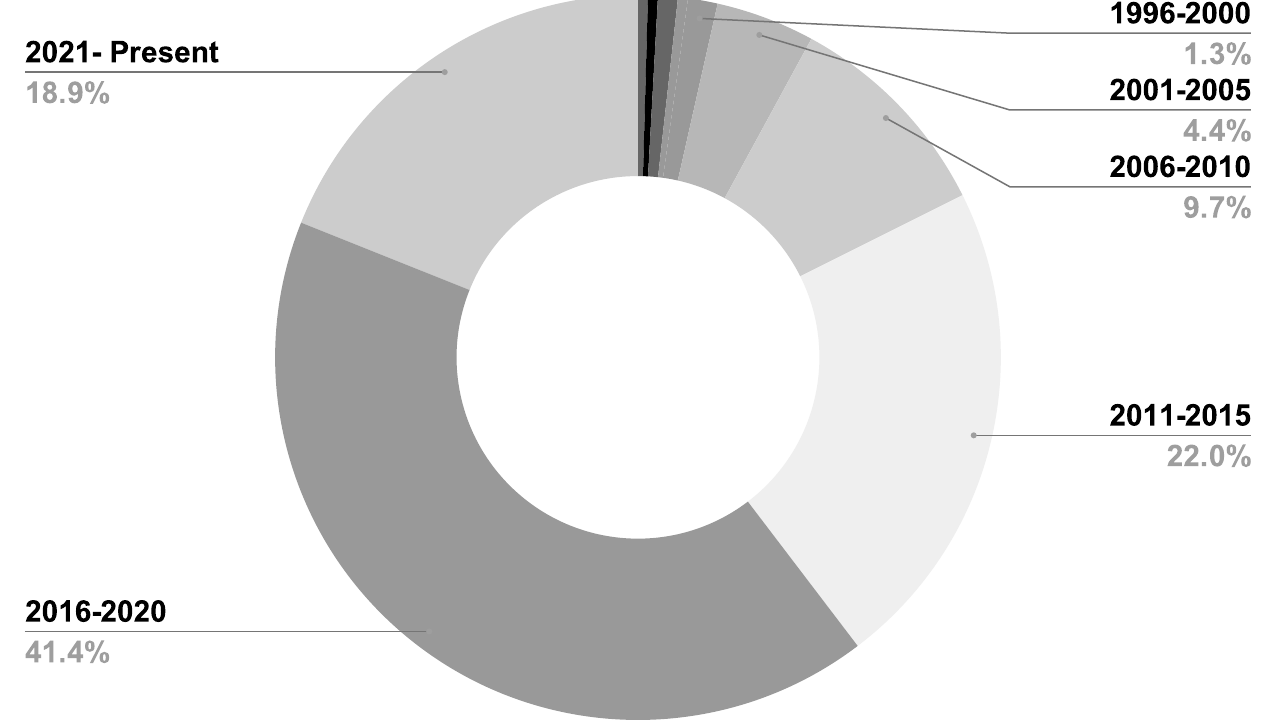
Figure 3. Number of papers per year, used in the review.